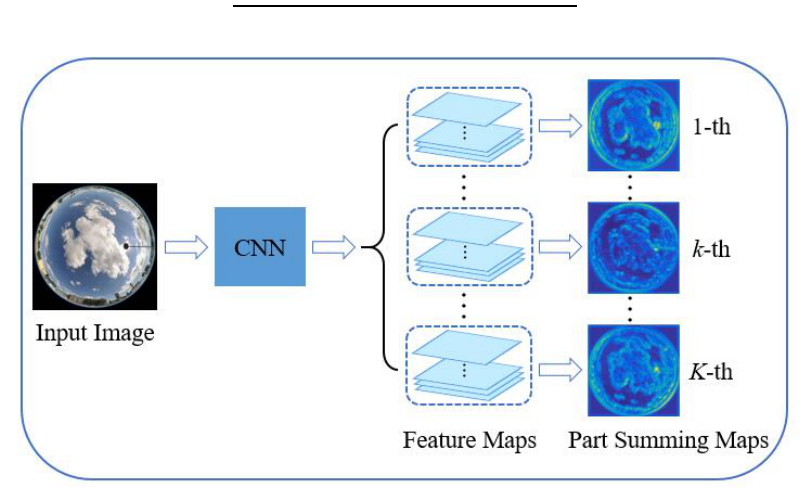
Figure 3. The procedure of generating part summing